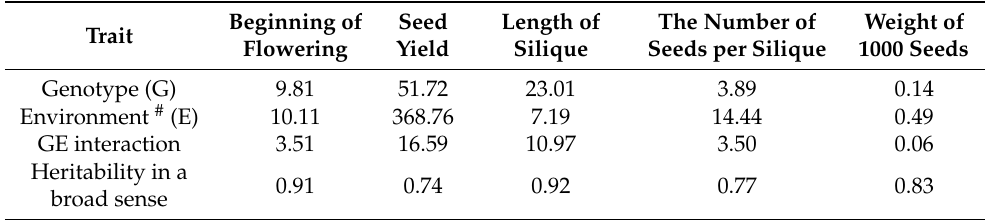
Table 6. The least-squares variance components for five observed traits of winter oilseed rape and heritability in a broad